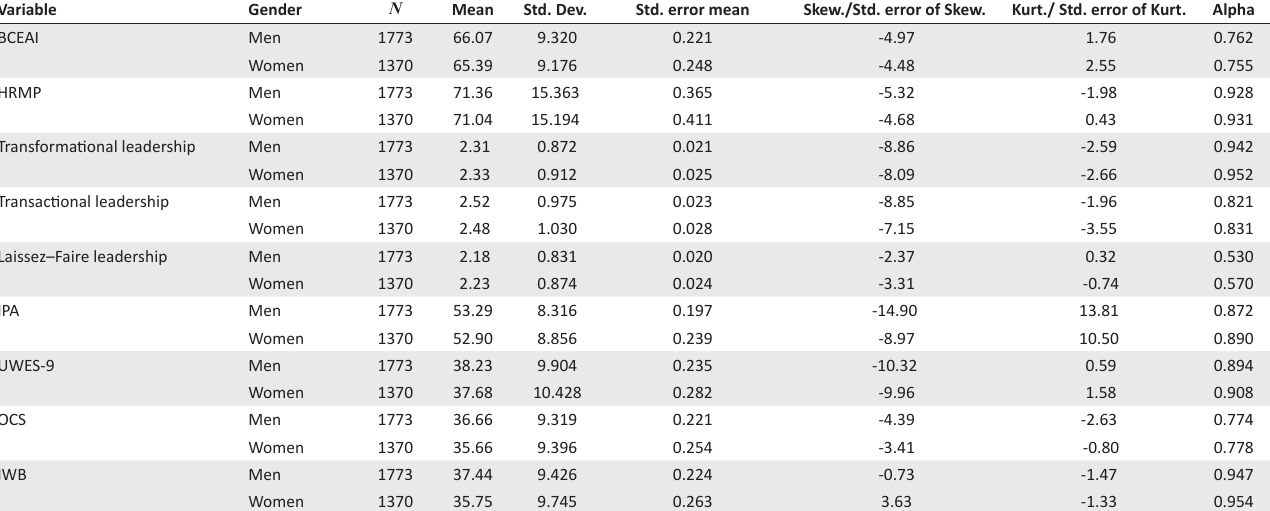
TABLE 1: Descriptive statistics, skewness, kurtosis and reliability.